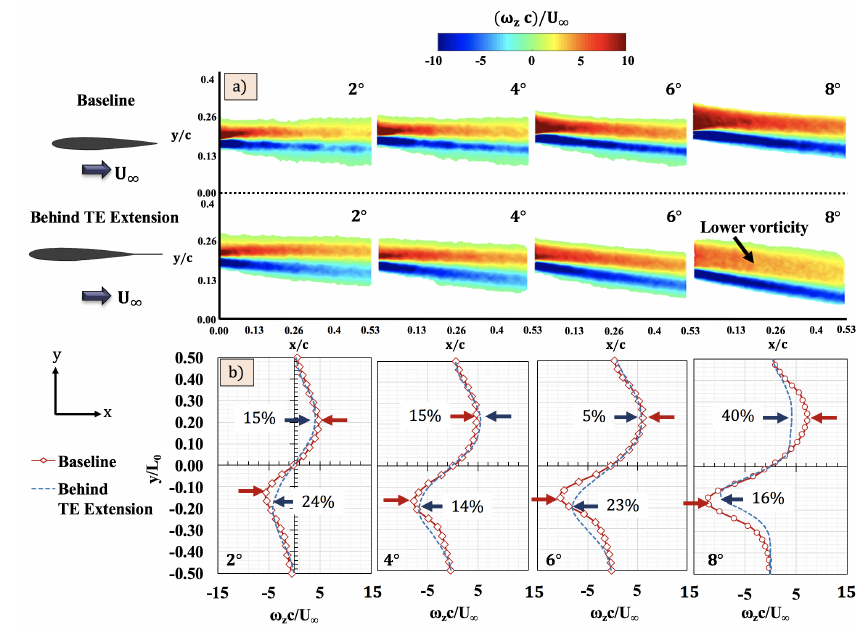
Figure 15. ( a ) Z-vorticity contours in FSL behind the trailing edge of the NACA 0012 wing and behind the TE extension ( b ) Vorticity profiles at different angles of attack for both cases. The local rotating velocity behind the TE extension is lower at higher and lower angles of attack when compared to the